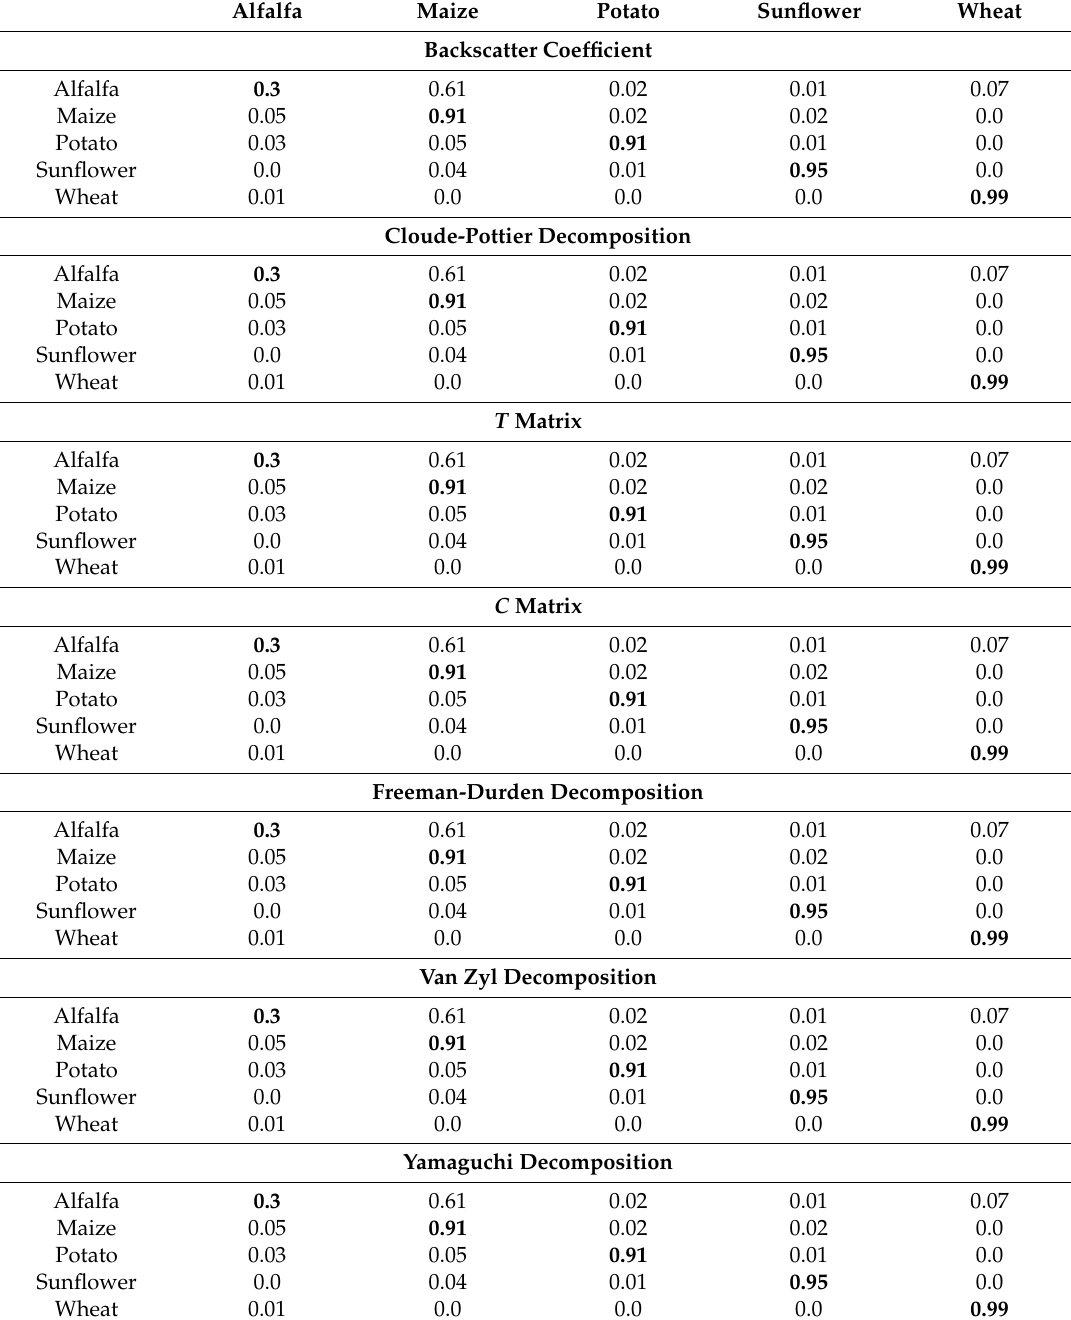
Table 6. Normalized confusion